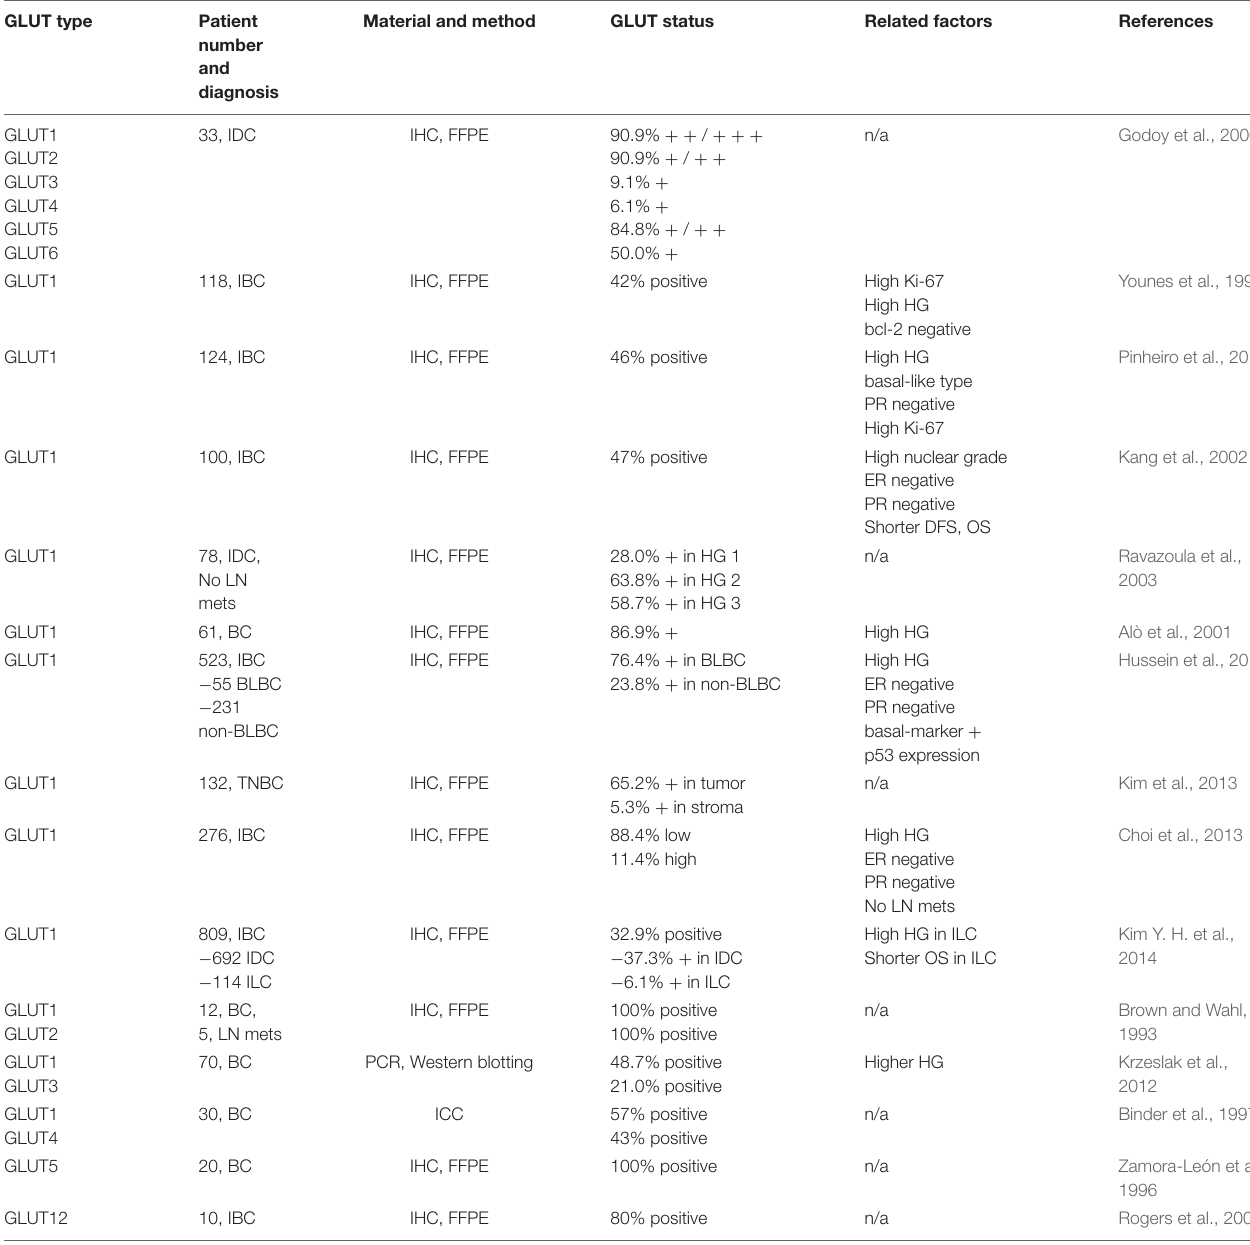
TABLE 1 | GLUT expressed in breast